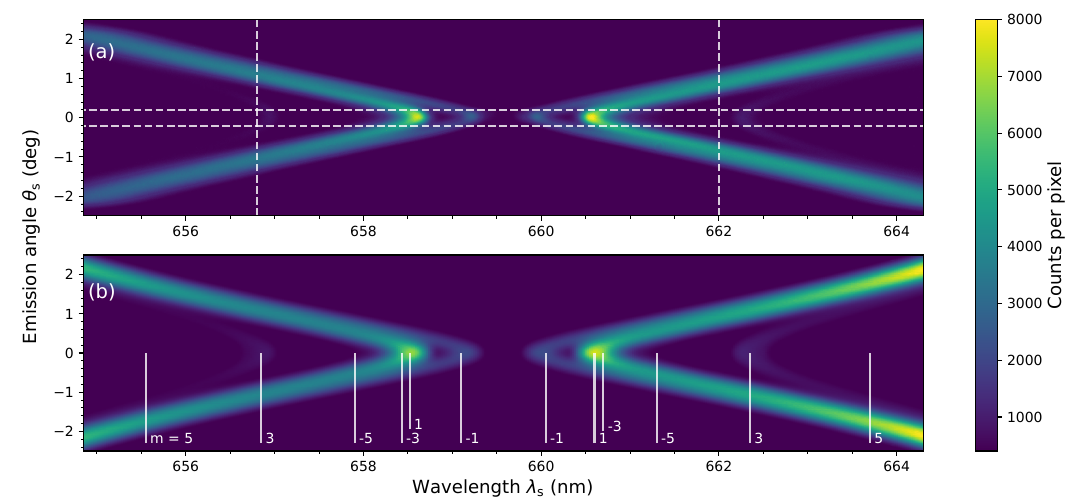
Figure 2: Experimental (a) and simulated (b) frequency-angular spectrum. The av- erage dark count rate is subtracted from the experimental spectrum. The dashed lines in (a) denote the location of the cuts presented in Fig. 3 and 4. The numbers m in (b) indicate the contributions of the different QPM orders. The tails on the left correspond to up-conversion, the ones on the right to